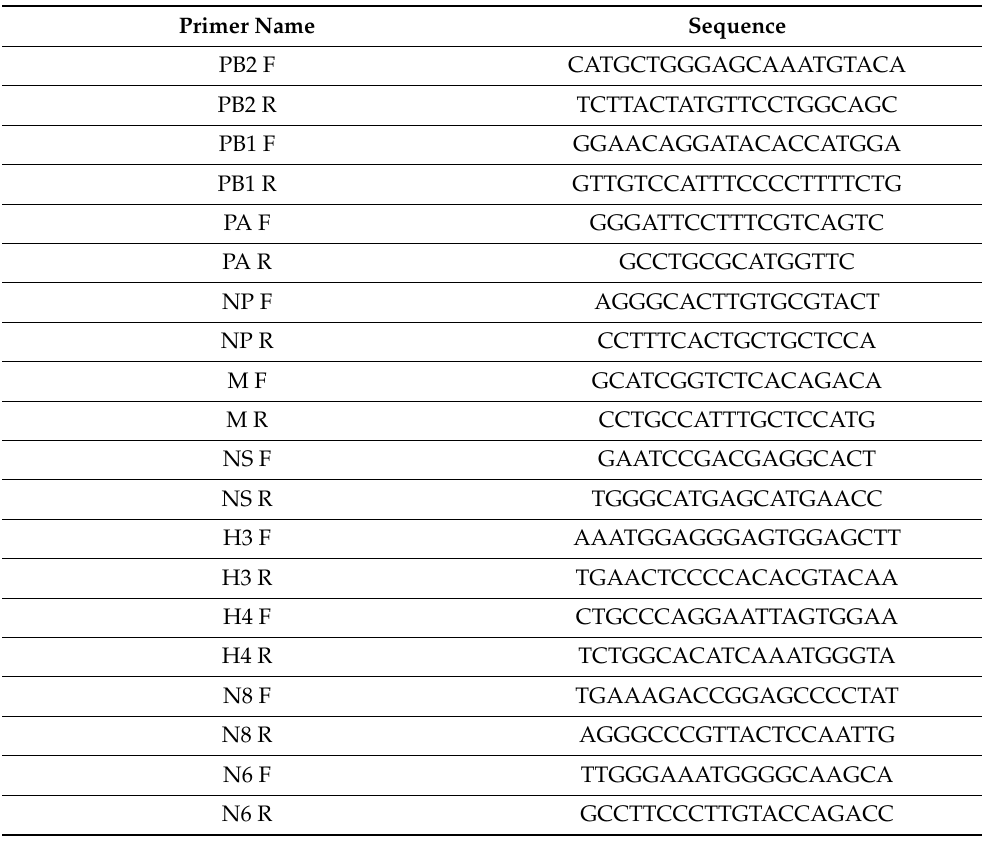
Table 1. Primers used for viral